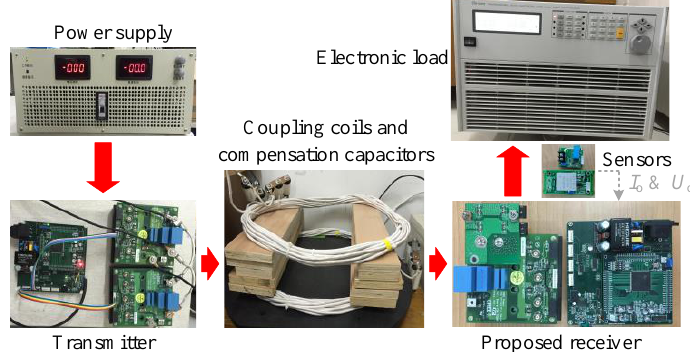
Figure 9. Prototype photograph of DPC system.